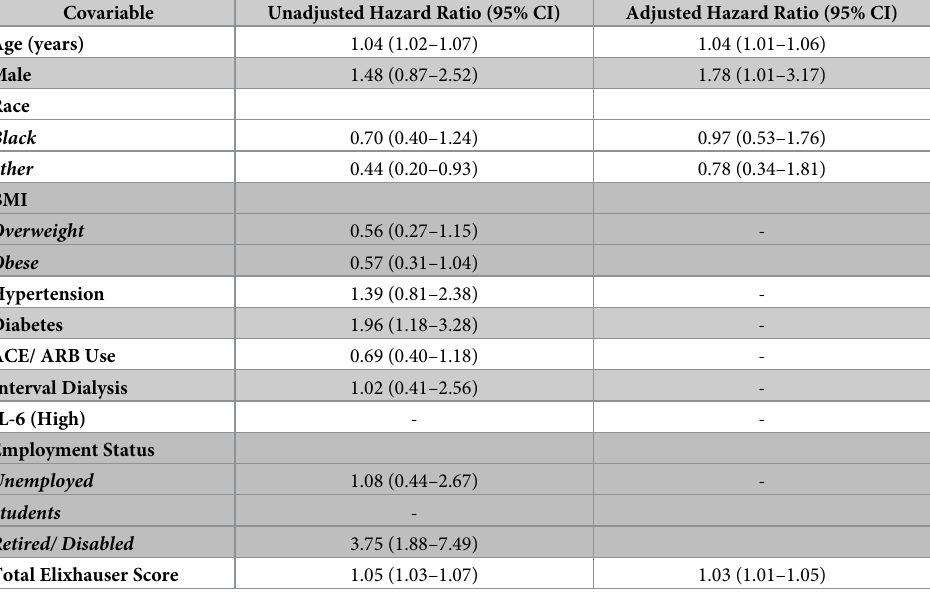
a conceptual framework and stepwise regression using a p-value of < 0.05. Backward stepwise regression models were conducted after a model had been designed based on a conceptual framework. The final model for mortality contained the following variables: age, sex, race, Table 2. Cox proportional regression showing association between covariables and